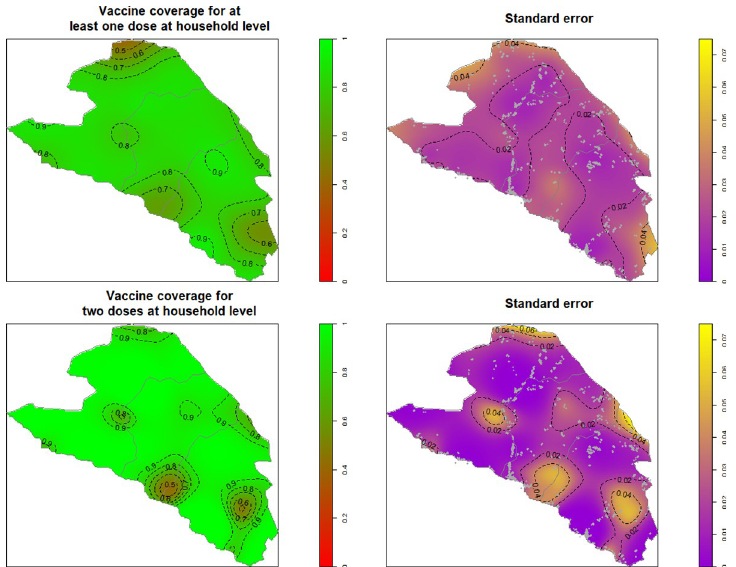
Fig 3. Interpolation of the spatial variation in self-reported cholera vaccination coverage, with standard error and position of GPS points, South Department, Haiti, 2017. Maps produced using R using GADM shapefiles for the boundaries.